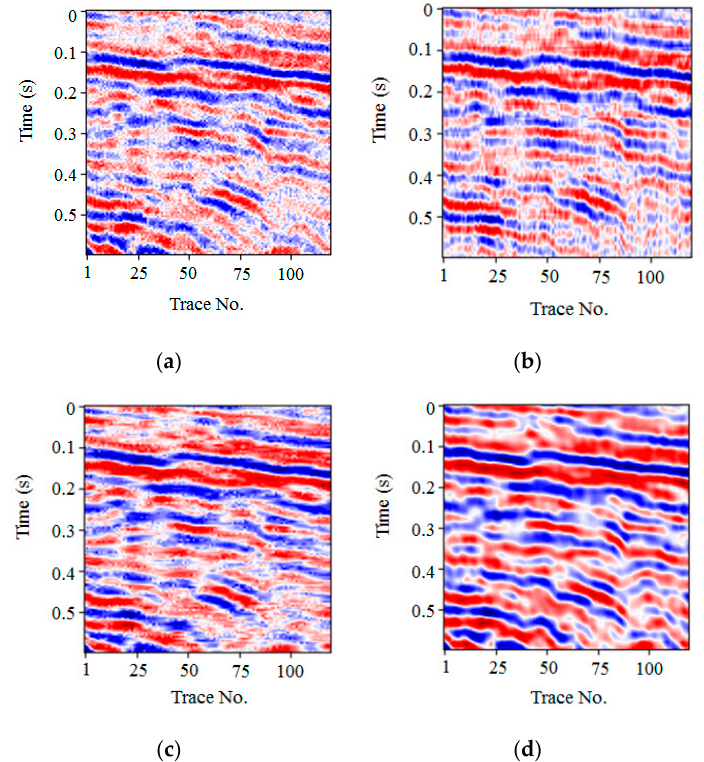
Figure 7. Denoised result comparison for synthetic data. Denoise results using ( a ) FXDECON (PSNR = 16.77 dB), ( b ) MSSA (PSNR = 15.01 dB), ( c ) wavelet transform (PSNR = 17.63 dB), and ( d ) the proposed method (PSNR = 21.00 dB).